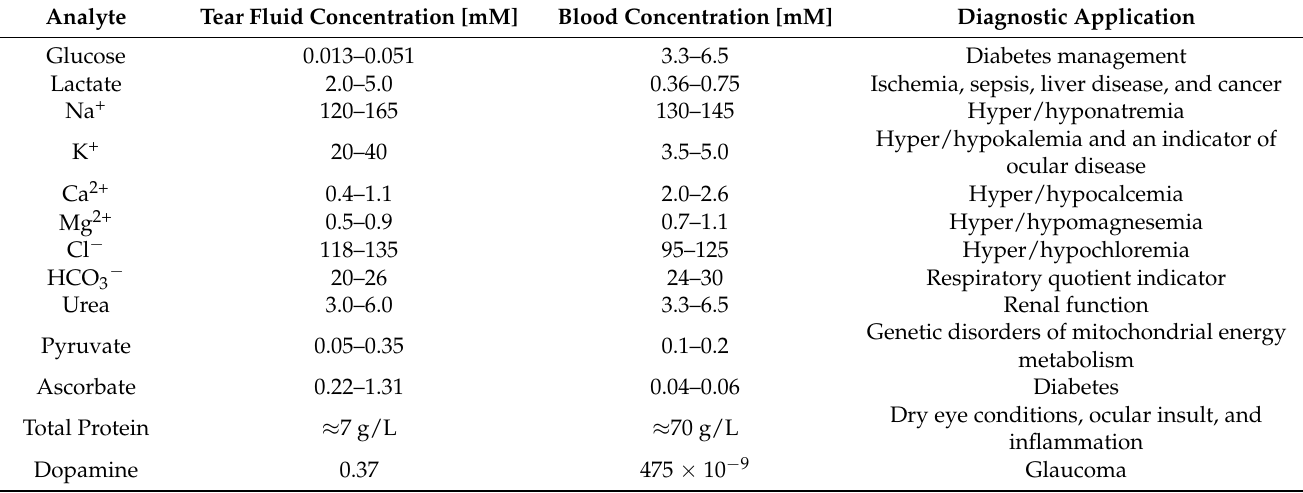
Table 5. The concentrations of major analytes in tears and their relative concentrations in the blood. Reprinted with permission from reference [114]. Copyright John Wiley and